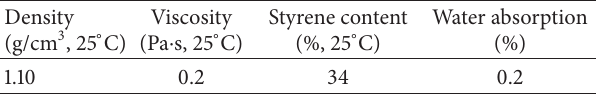
Table 1: Physical properties of binder used.